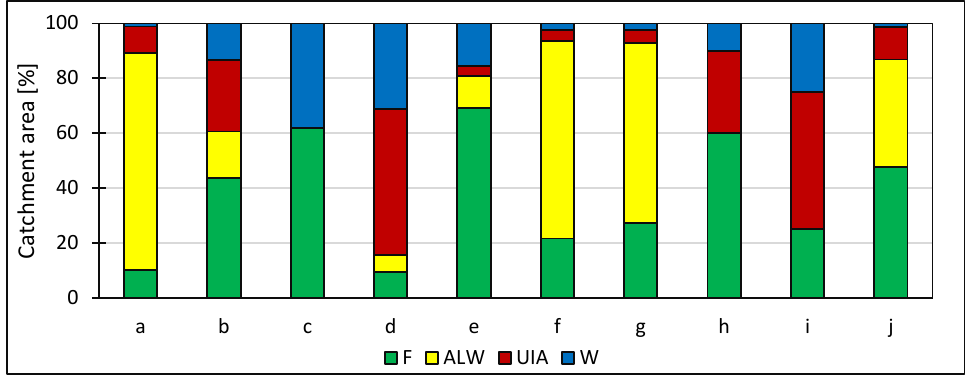
Figure 3. Land use forms in catchments of water bodies in the Silesian Upland and its periphery as catchment-area percentages. Land use forms: F—forest, ALW—agricultural land and wasteland, UIA—urban and industrial areas, W—water. Water body catchments (with outlets specified): a— Dzierżno Małe catchment area, b— Pogoria III catchment area (including the Pogoria I reservoir), c—Chechło catchment area 1, d—catchment areas of water bodies (including the Stawiki, Morawa and Gliniak), e—Sosina catchment area, f—Pławniowice catchment area (including the Mały Zalew reservoir), g—Rogo´znik I catchment area (including the Rogo´znik II reservoir), h—Balaton catchment area, i—Koparki catchment area, j—Paprocany catchment